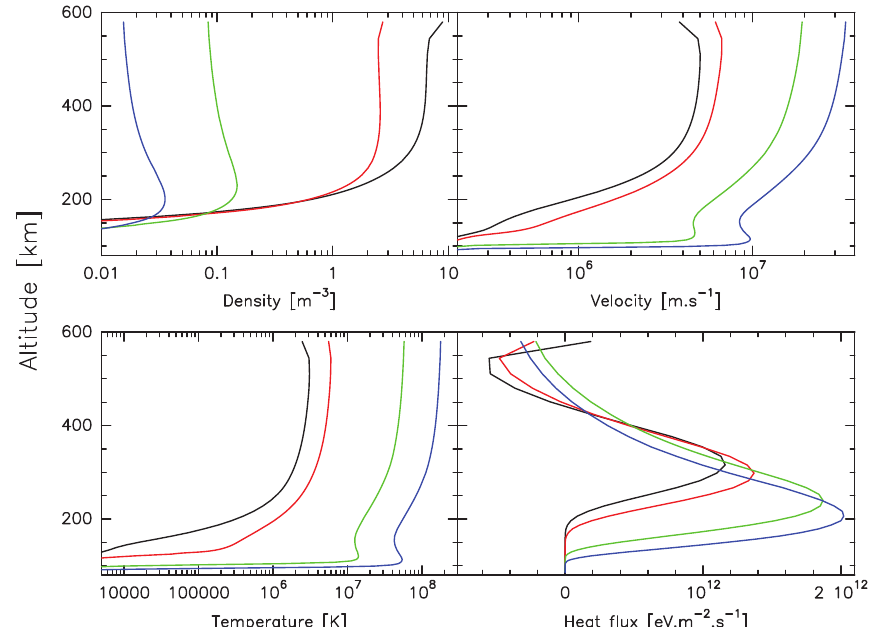
Fig. 10. Electron moments for a mean energy E o = 500 eV (black), 1 keV (red), 10 keV (green) and 100 keV (blue) and a similar total energy E tot = 5 erg.